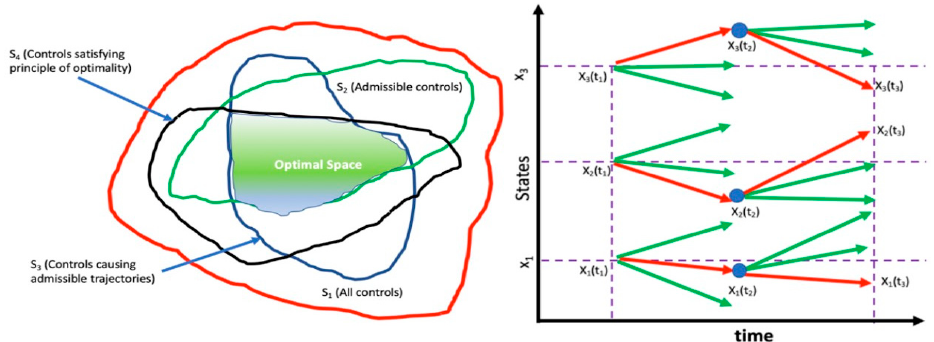
Figure 4. Illustration of dynamic programming solver.